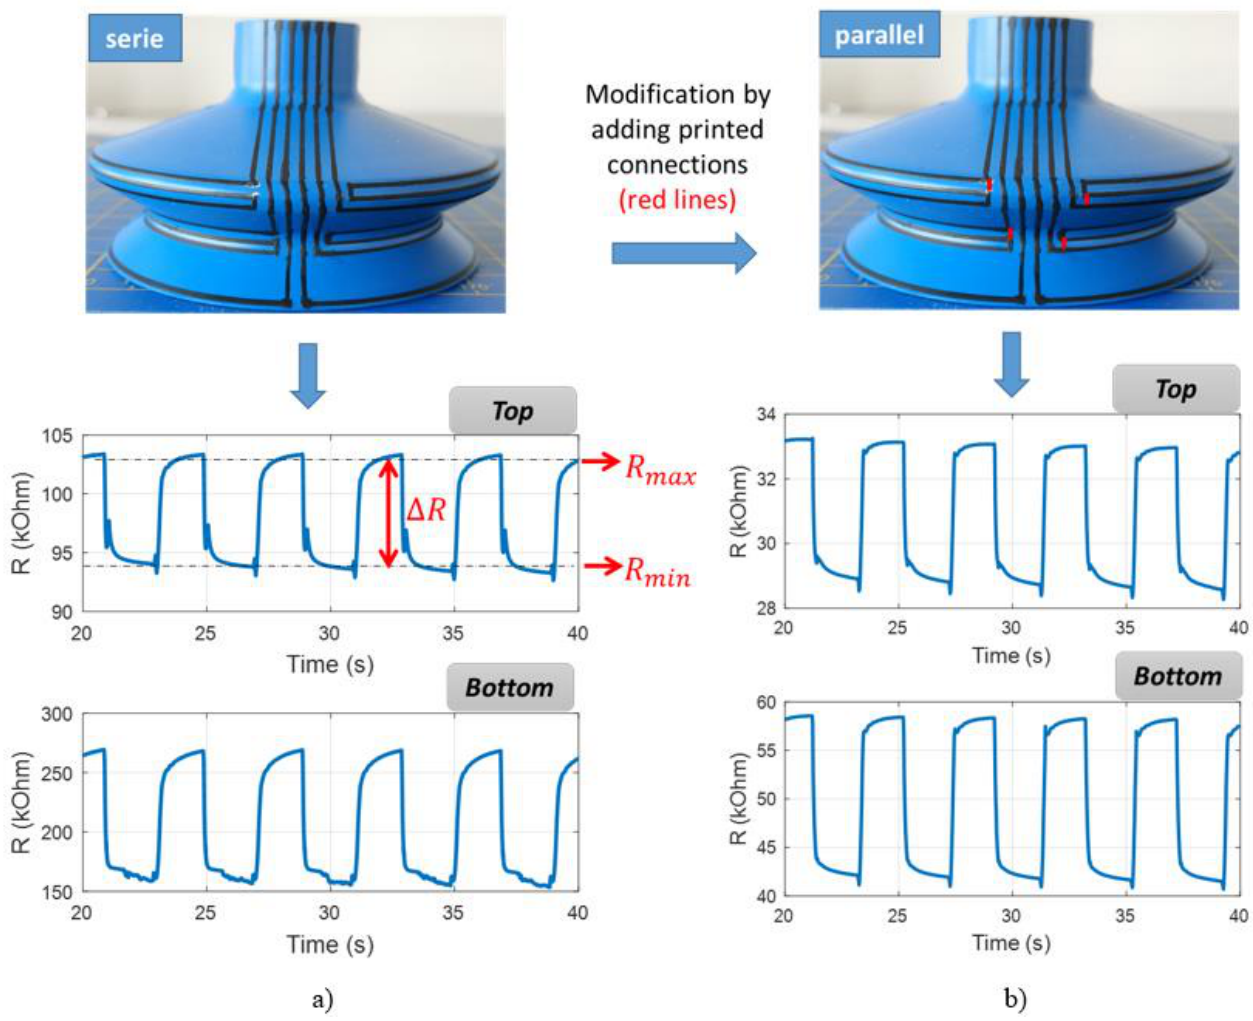
Figure 17. Time evolution of the three-circle resistances in ( a ) serial connection or ( b ) parallel connection coated on a 3D suction cup. Table 4. Comparison of the absolute and relative resistance variation of three SC coating designs.